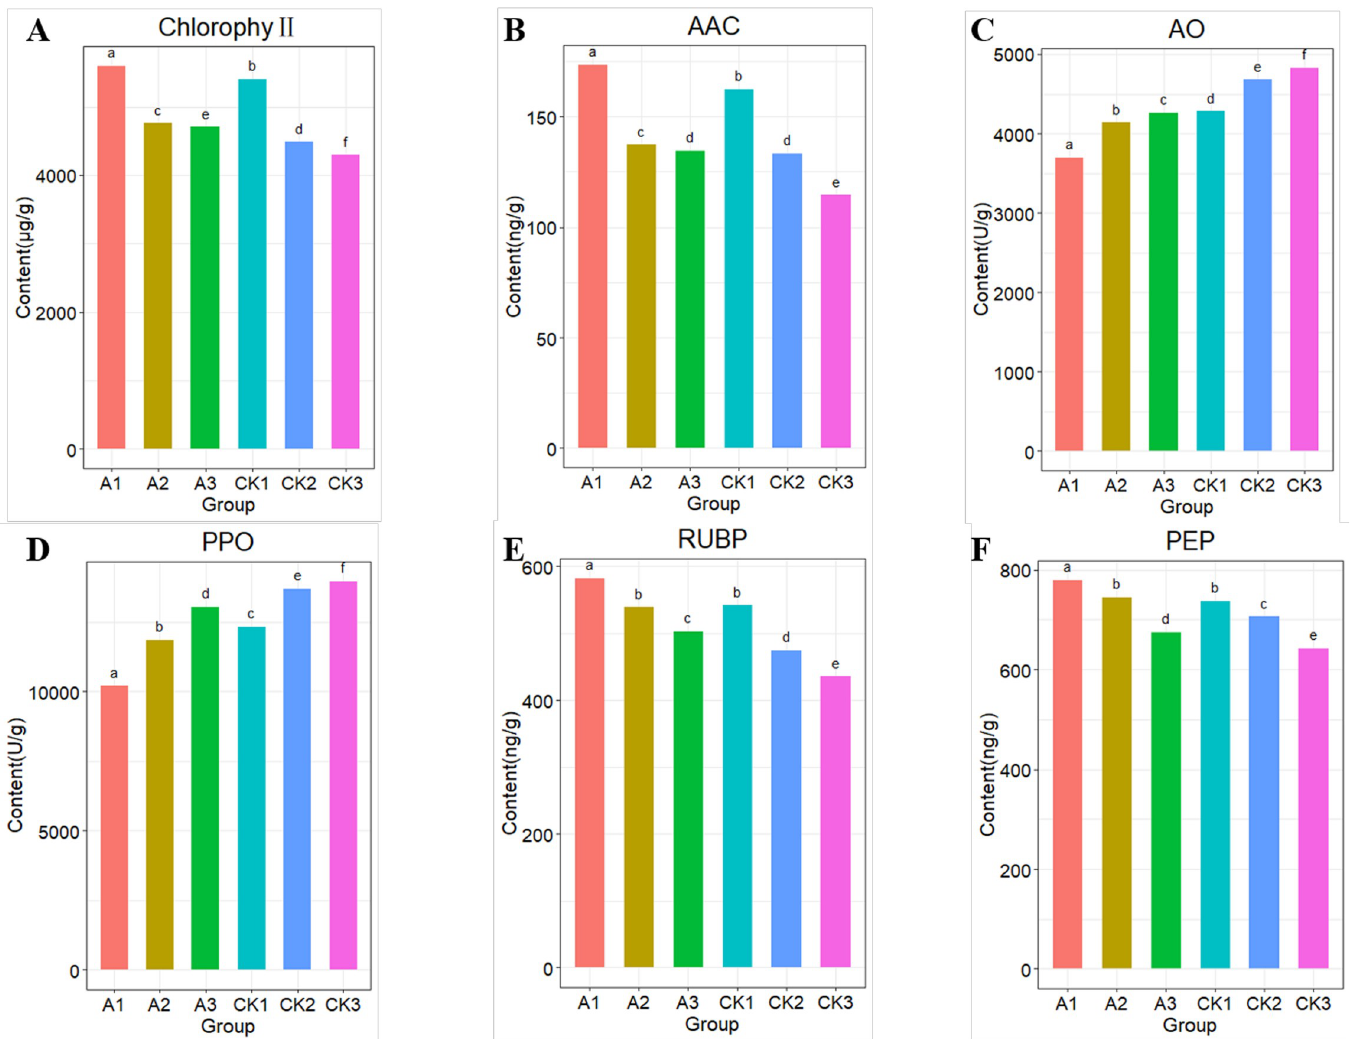
Fig 1. Photosynthetic related physiological indexes of apple leaves after reduce density. Lower case letters above the column in the figure indicate significant differences between treatments at the P < 0.05